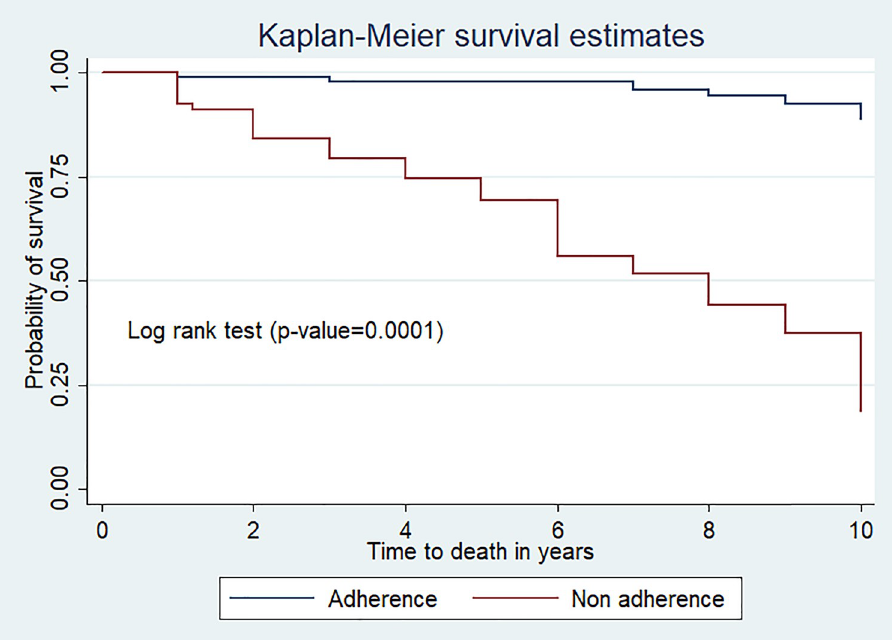
Fig 4. Kaplan Meier survival curve of ART adherence level among TB/HIV co-infected children at seven public hospitals, Southern Ethiopia.